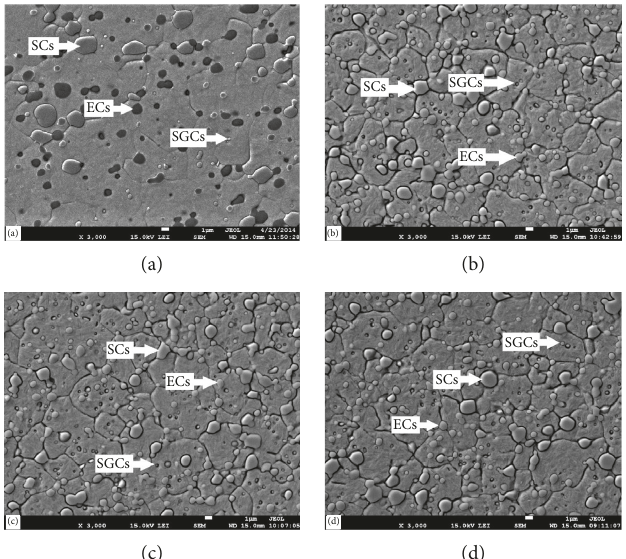
Figure 3: SEM micrographs showing the microstructure of Vanadis 6 steel (a) after CHT, (b) after SZT at − 140 ° C for 4h, (c) after SZT at − 140 ° C for 24h, and (d) after SZT at − 140 ° C for